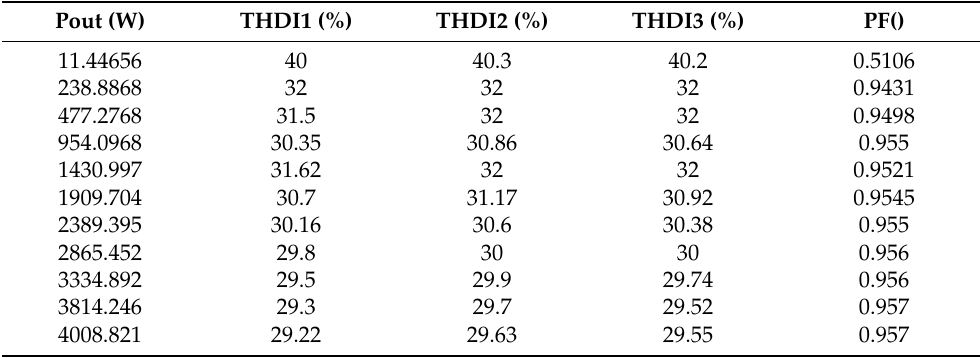
Table A2. THD and PF parameters for original transistor SiC IMW120R060M1H and ferrite inductor (operating frequency 120 kHz).